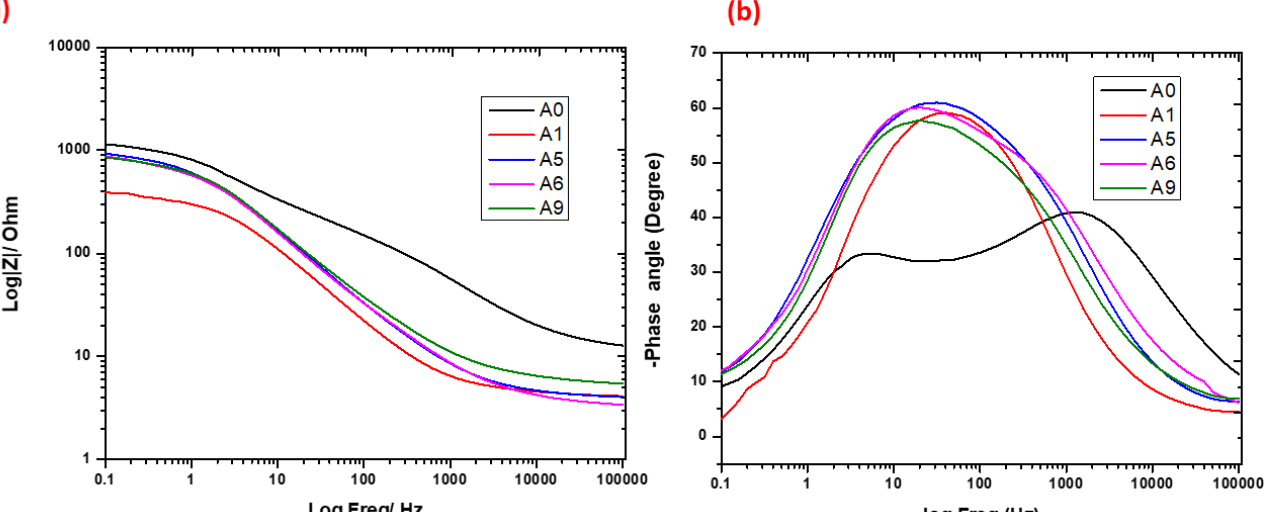
Figure 7. ( a ) Bode profiles, ( b ) Bode phase profiles of samples in 3.5% NaCl for 72 h. Table 4 shows the samples’ EIS fitting outcomes for solutions containing 3.5 wt.% NaCl. R ct stands for the samples’ corrosion resistance in the solution. The thin oxide film that forms on the sample surfaces determines how resistant the samples are to corrosion. This could have restricted ionic and electronic conductivity and slowed down electro ‐ chemical reactions on the samples’ surfaces [38].